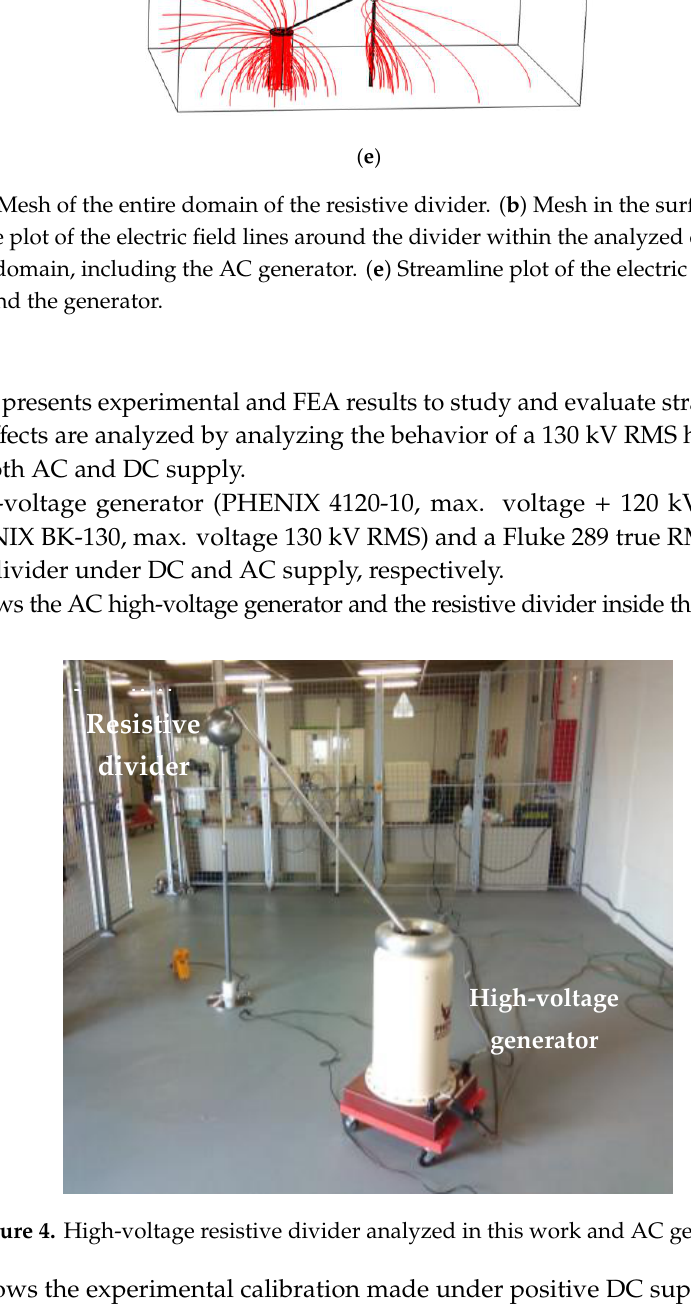
Figure 4. High-voltage resistive divider analyzed in this work and AC generator.